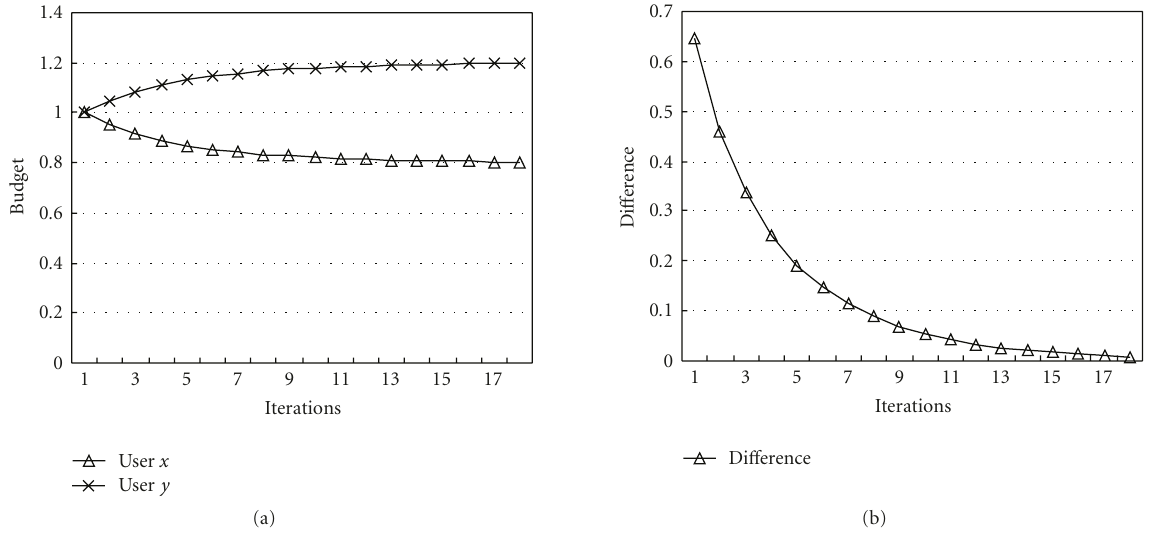
Figure 3: Convergence of iterative algorithm for balancing individual